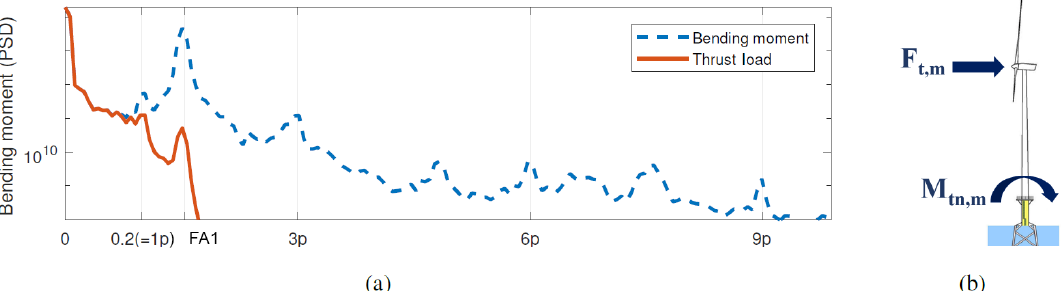
Figure 1. (a) Frequency spectrum of measured tower bending moment in the fore–aft direction during 10min (blue dashed line). The quasi- static part of the bending moment is filtered out (red solid line). The targeted quasi-static load (filtered) no longer contains the effects of rotor harmonics. (b) The measured thrust load F t , m is obtained using the bending moment M tn , m measured by strain gauges located at the interface between tower and transition piece.